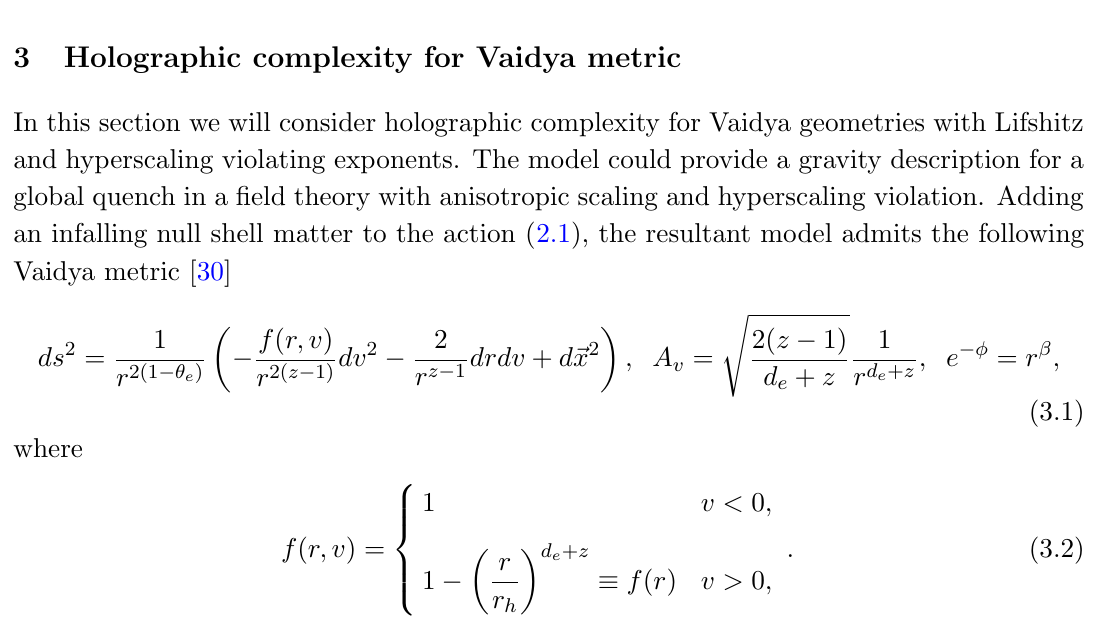
Figure 3 . WDW patch of a one sided black brane, i.e., Vaidya geometry. The orange line is the in-falling collapsing null shell located at v =